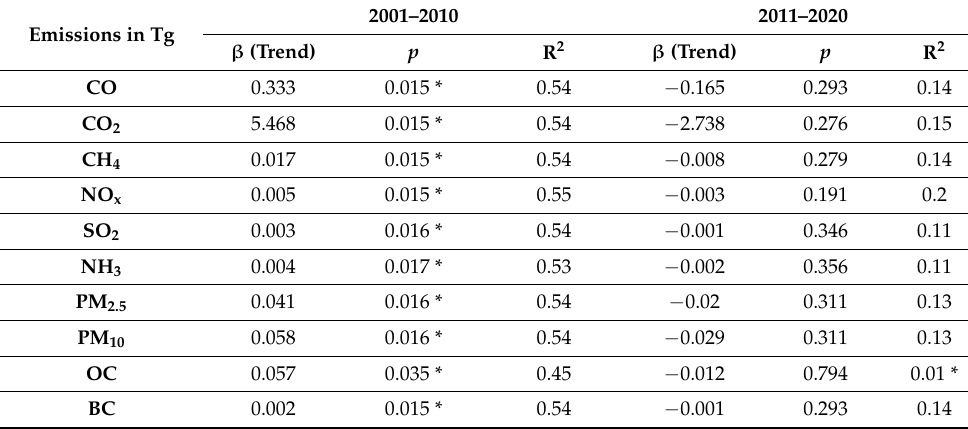
Table 4. Decadal linear trends (Tg year − 1 ) of forest fire emissions over the entire study area. Emissions in Tg